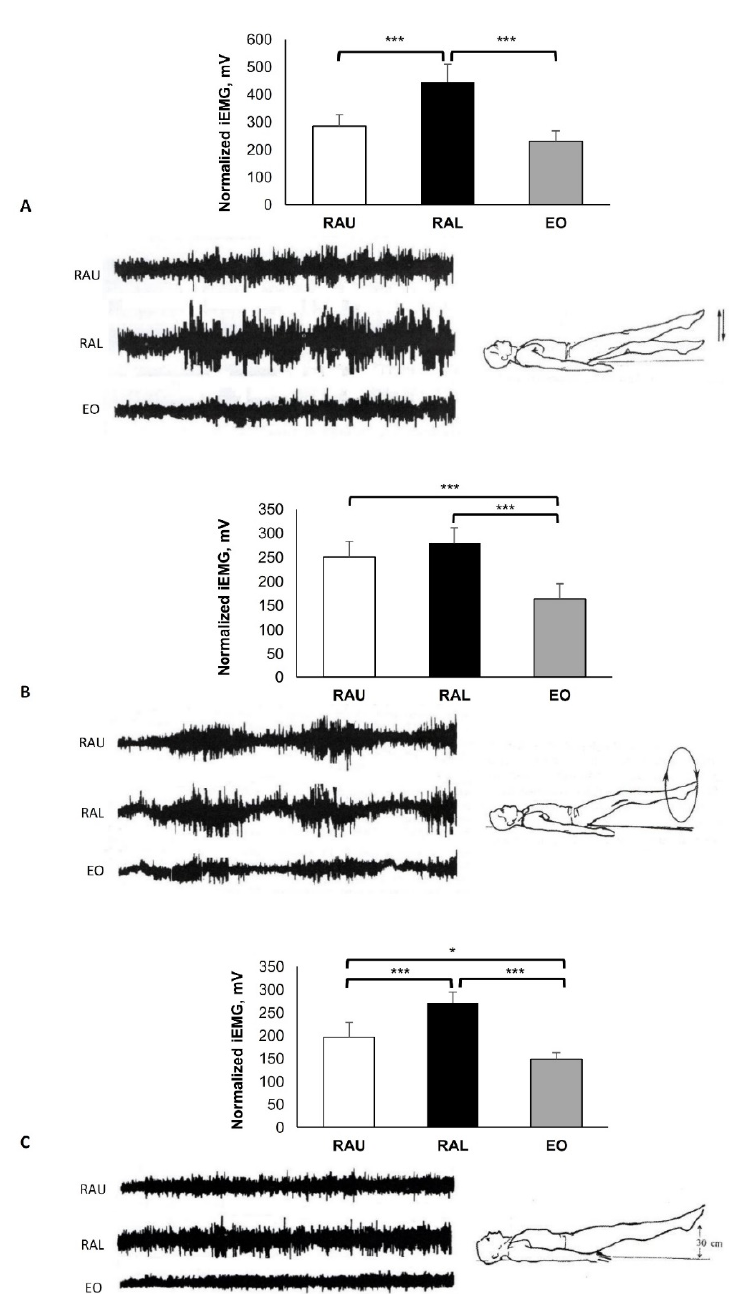
Figure 3. Long lying. Dynamic exercises: ( A ) Scissors exercise, ( B ) in circles, and ( C ) straight legs rising 30 cm from the floor with isometric contraction for 10 s ( C ). Group mean electric activity during the exercise. iEMG indicates surface electric activity. Raw EMG activity of the three muscles from one participant. RAU = rectus abdominis upper part; RAL = rectus abdominis lower part; EO = external oblique. Differences between muscles: * p < 0.05; *** p < 0.001). Figure 6: Starting position: Lying position with hips and knees flexed 90 ◦ , above the floor. Posterior pelvic tilt and lifting the hips (gluteal region) from the floor through the direction of the knees. The arms were parallel with the body and pressed to the floor. The isometric contraction was approximately 10 s. This exercise had not been previously examined by means of EMG